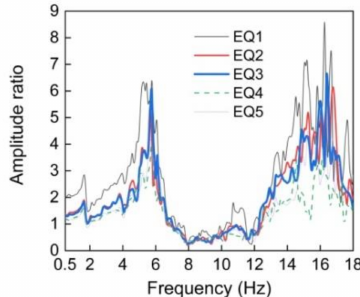
Figure 8. The amplitude ratios of the transfer function of the acceleration measured at A-1 (slope crest) and A-0 (bottom of the model box) in the 2# model during centrifuge